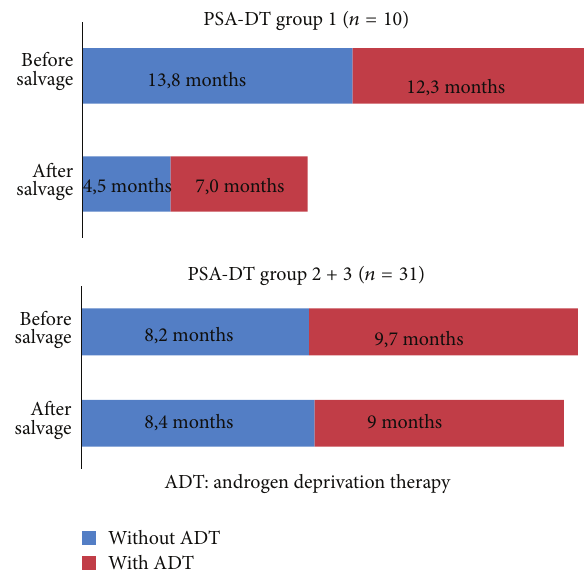
Figure 4: Localisation of LN metastasis ( 𝑛 = 41 ). Average of removed LNs per operation: 16.6. 𝑛 = 765 (LNs in total).